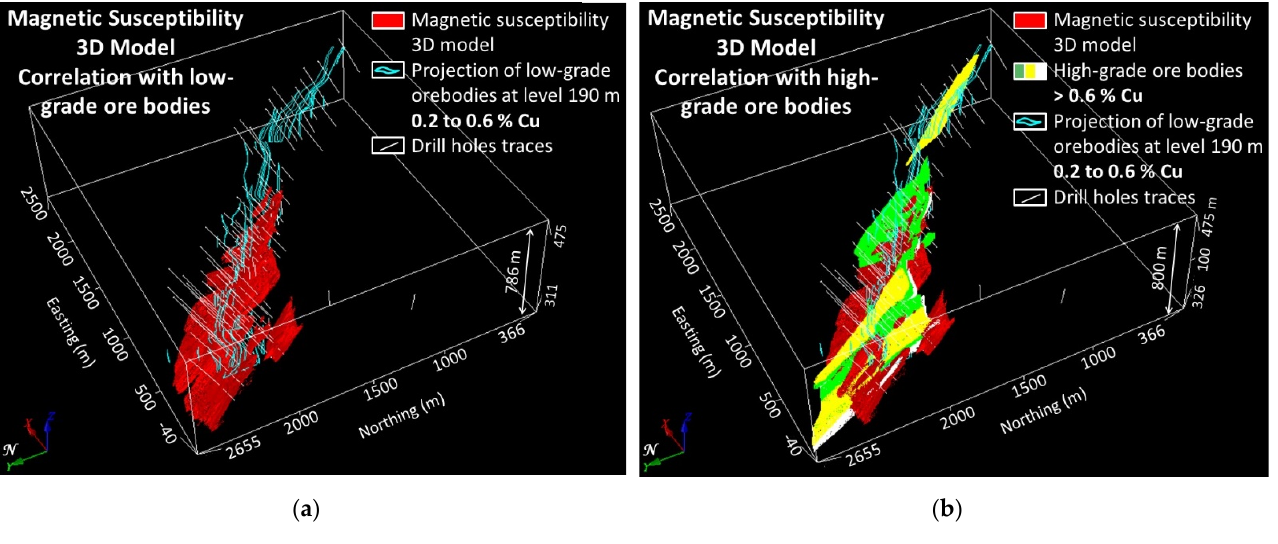
Figure 21. ( a ) Correlation of the three-dimensional magnetic susceptibility model with the projection of low-grade copper orebodies (0.2 to 0.6% Cu) at the level 190 m. ( b ) Correlation of the three- dimensional magnetic susceptibility model with the high-grade copper orebodies (ore threshold limit higher than 0.6% Cu) from extensive drilling. The isosurface cutoff of the 3D magnetic susceptibility model with predominant ferrimagnetic mineral footprints show values greater than 500 × 10 − 3 SI for the high-sensitivity equipment (KT-10) and values greater than 60 × 10 − 3 SI for those measured with the low-sensitivity equipment (KT-9).